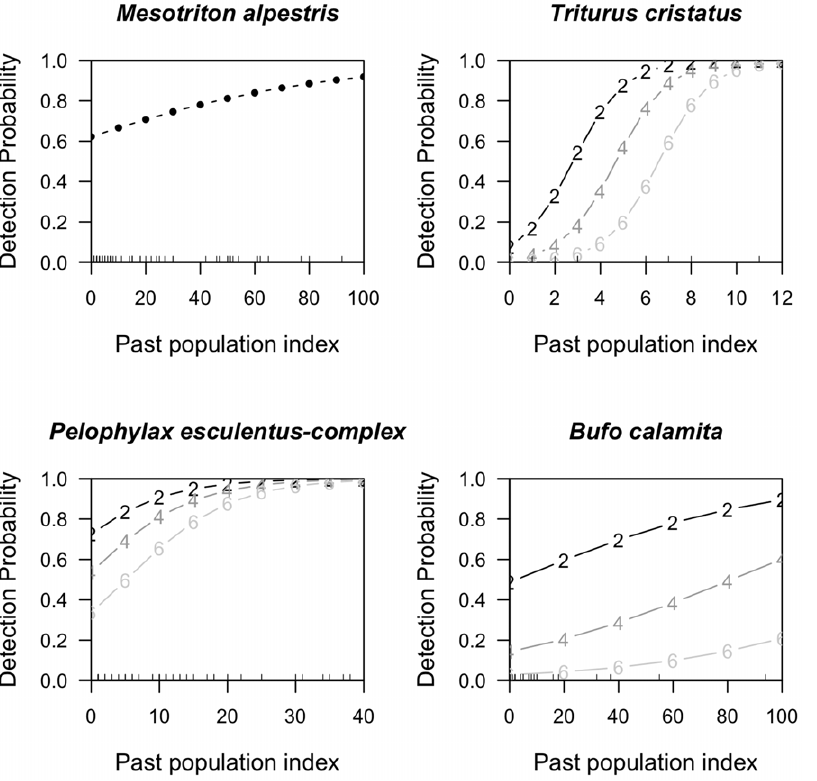
Figure 2. The relationship between past population index, time since last survey (two, four and six years ago) and detection probabilities in two anurans and two newts. Small ticks inside the box indicate observed population sizes.